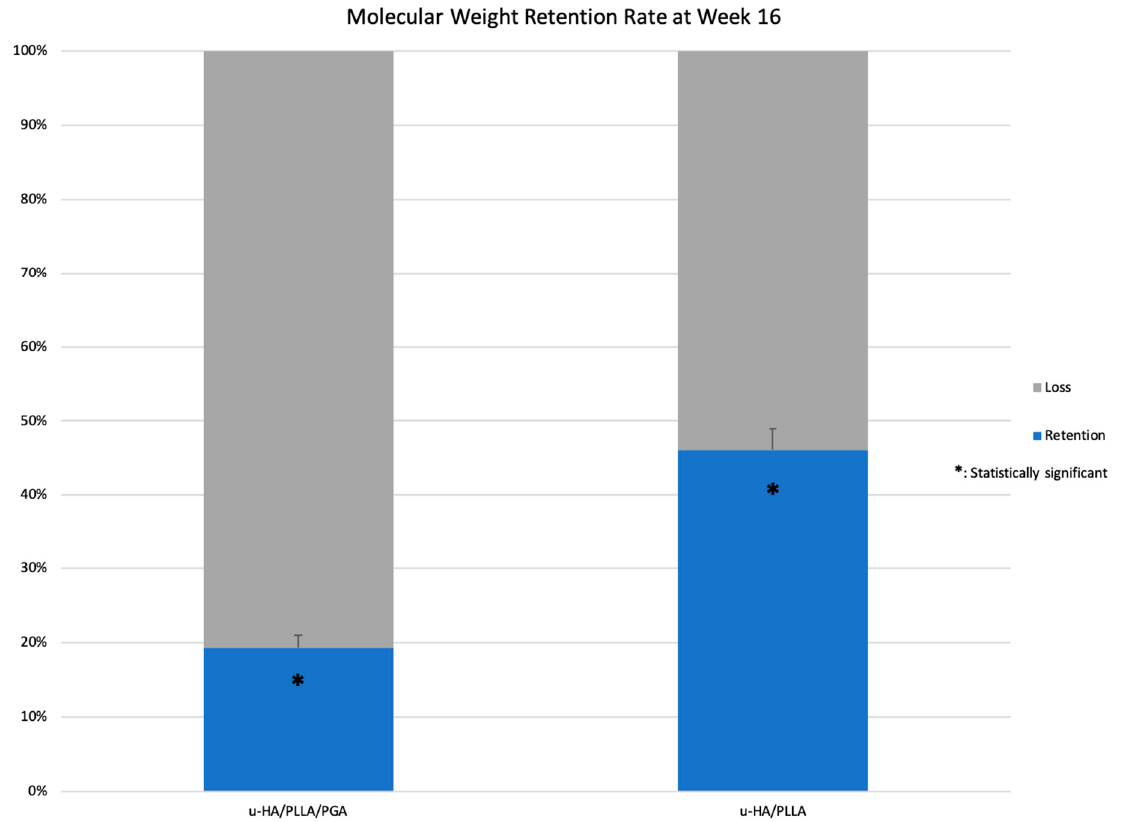
Figure 16. Retention rates of u-HA/PLLA/PGA and u-HA/PLLA. * p < 0.05.